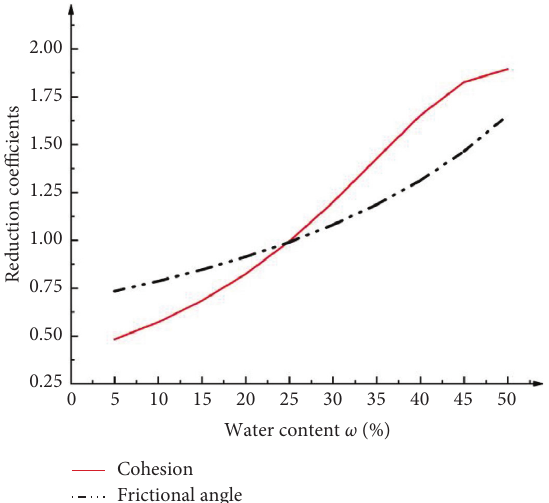
Figure 11: The variations in the reduction coefficients of the cohesion and friction angle with water